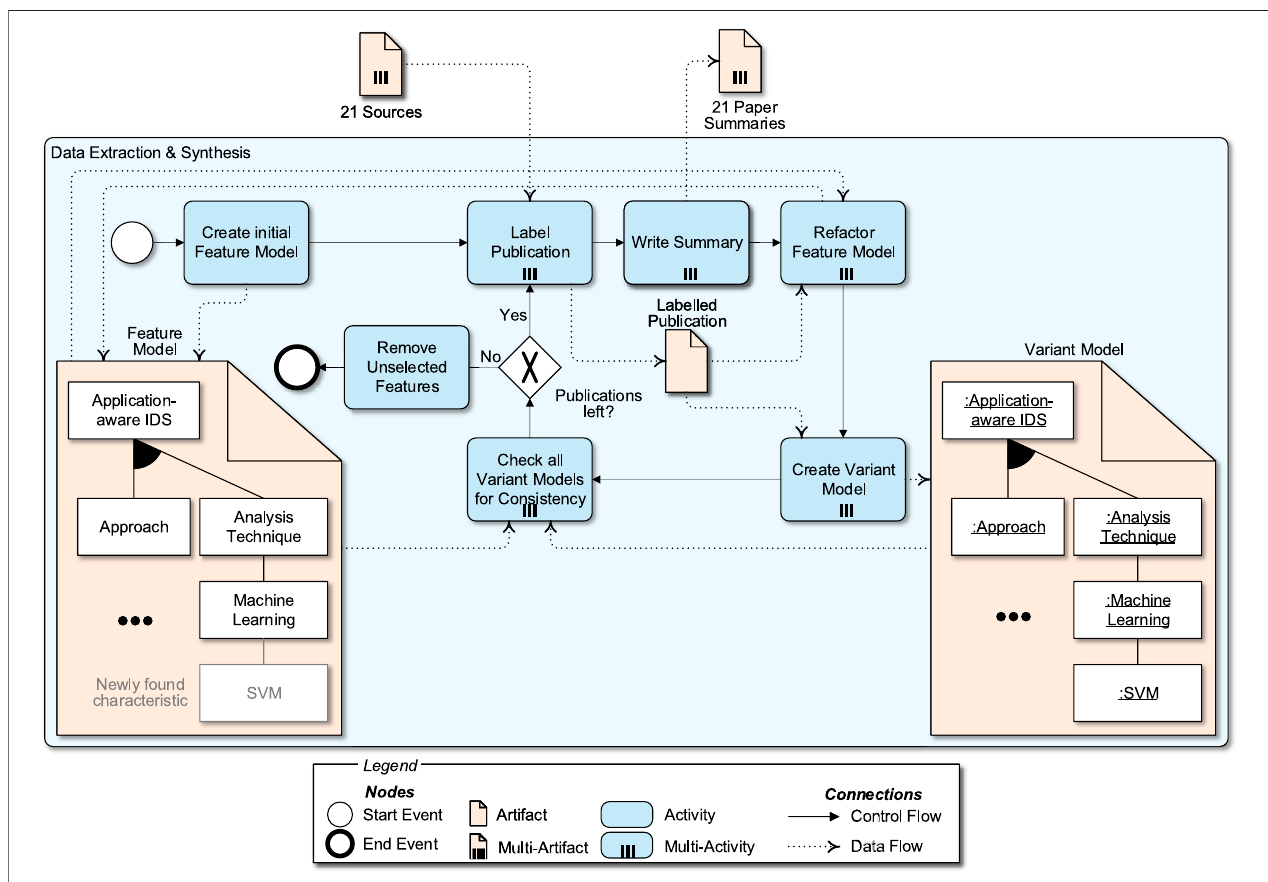
FIGURE 11 | The data extraction and synthesis